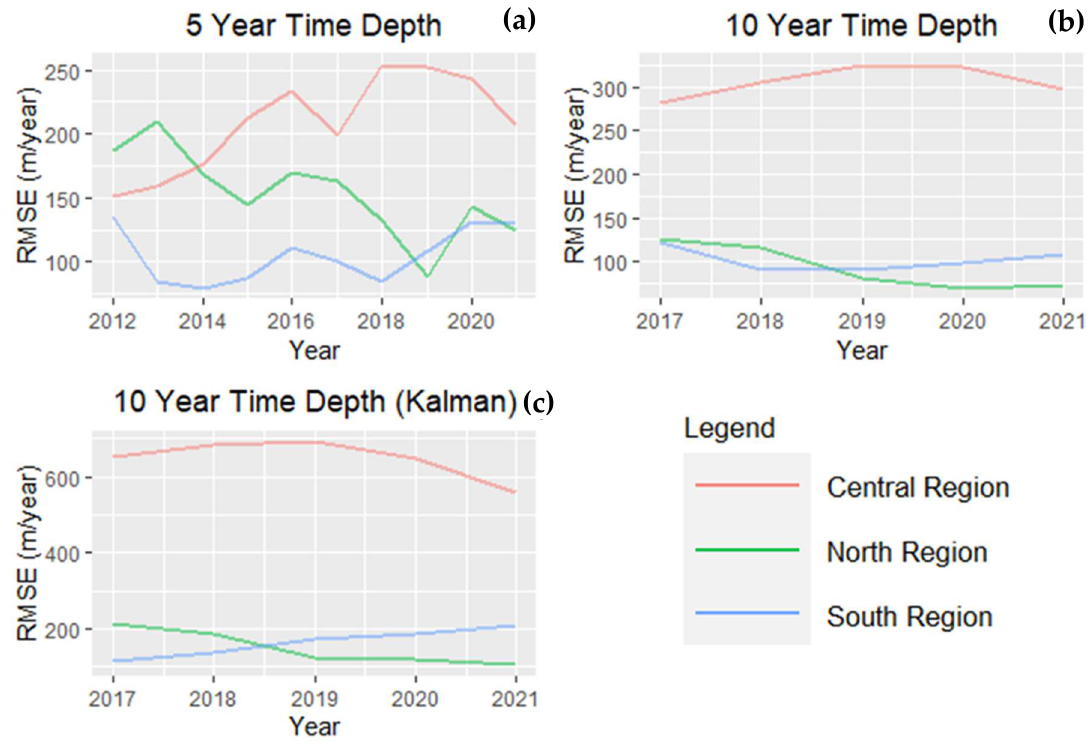
Figure 8. Variations in RMSE values calculated using the LRR rates data for predicting 20 years in the future: ( a ) 5 years’ time depth, ( b ) 10 years’ time depth, and ( c ) 10 years’ time depth (Kalman).